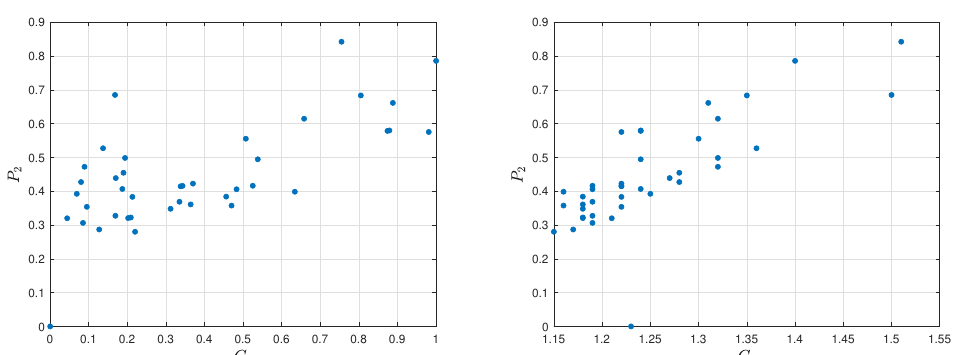
Figure A1. The relation diagram of Total kills ( C 3 ) for assessment P 2 ( left side ) and K/D Ratio ( C 4 ) for assessment P 2 ( right side